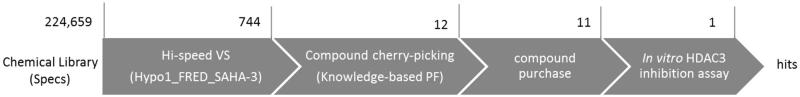
The workflow for the discovery of novel HDAC3 inhibitors. The number refers to the amount of chemical entities that entered the next component of the workflow.